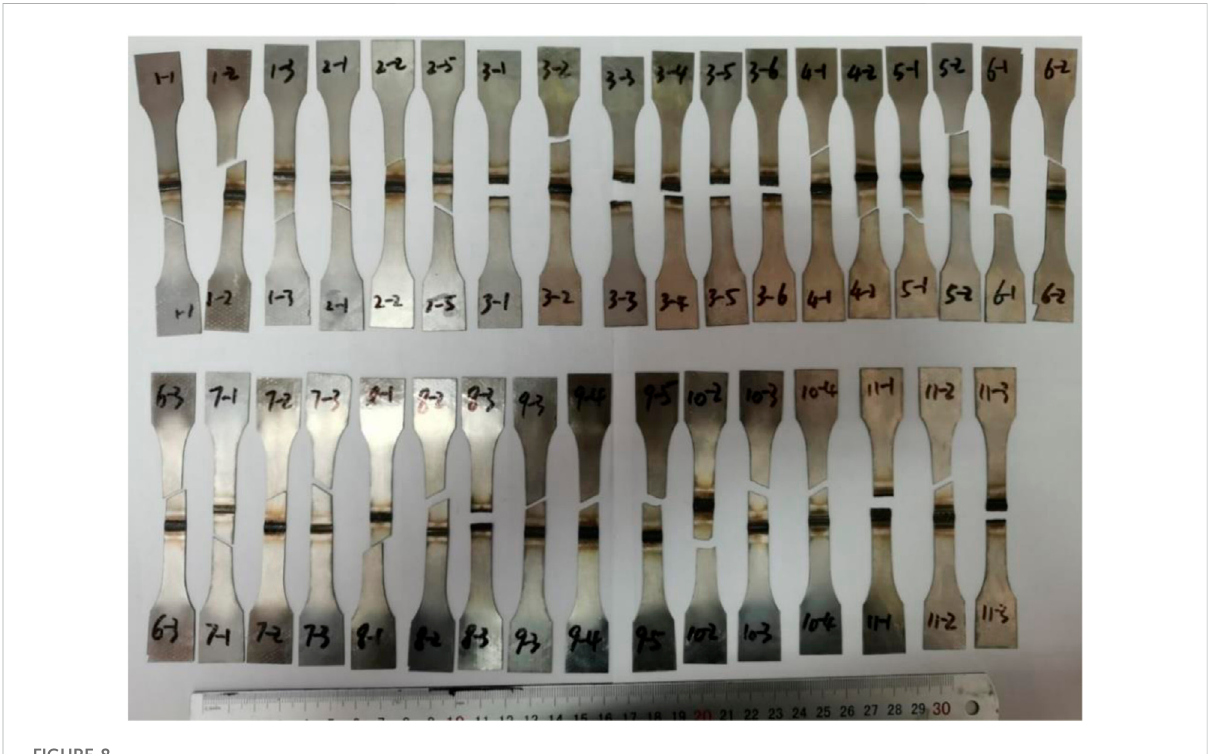
FIGURE 8 Specimens after tensile testing.